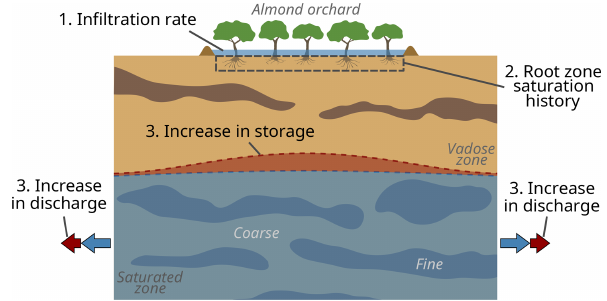
Figure 1. Theoretical cross section of flood-MAR at an almond or- chard, showing processes that determine the three outcomes of in- terest considered in this study: infiltration rate at the surface (1), root zone residence time (2) and saturated-zone recharge effi- ciency (3). Saturated-zone recharge efficiency consists of two com- ponents: storage recharge (the increase in saturated-zone storage be- low a site) and flux recharge (the increase in lateral discharge away from the site below the water table). Red colors indicate long-term changes from pre-inundation